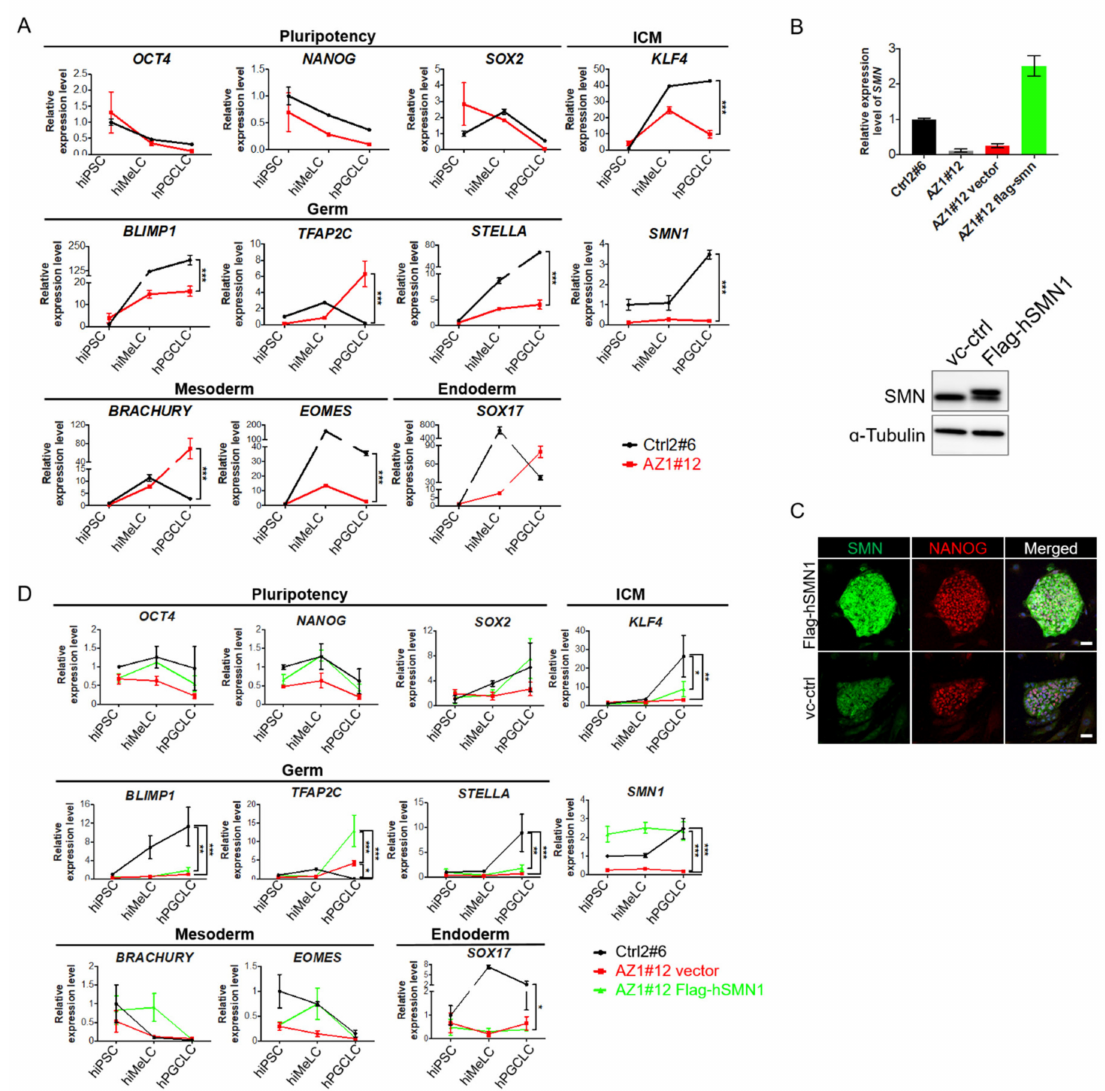
Figure 4. Effect of hSMN1 overexpression on hPGCLC induction in hiPSC from azoospermia patients. ( A ) Expression analysis by real-time RT-PCR of hiPSCs, hiMeLCs, and hPGCLCs. Pluripotent markers including OCT4 , NANOG and SOX2 , as well as ICM marker KLF4 are down-regulated upon differentiation, whereas germ cell markers such as BLIMP1 , TFAP2C, and STELLA are up-regulated during differentiation in control hiPSC (Ctrl2#6). Mesoderm ( BRACHYURY , EOMES ) and endoderm marker ( SOX17 ) show the increasing tendency during differentiation. SMN1 expresses abundantly in cells from Ctrl2#6 hiPSCs compared with AZ1#12 group. Relative expression levels are shown with normalization to GAPDH . Error bars indicate mean ± SEM from three replicates (two-way ANOVA, * p < 0.05; ** p < 0.01; *** p < 0.001). ( B ) Comparison of SMN1 transcripts (upper panel) in Ctrl2#6 and AZ1#12 hiPSC by real-time RT-PCR. Relative fold change of SMN1 is significantly elevated in Flag-hSMN1 overexpressed AZ-hiPSCs (Flag-hSMN1) compared with vector control (vc-ctrl). Western blot analysis demonstrates the exogeneous Flag-tagged SMN protein in SMN overexpressed group (Flag-hSMN1) in 4i culture condition. α -Tubulin is used as internal control (lower panel). ( C ) Immunofluorescent staining of Flag-hSMN1 overexpressed AZ-hiPSCs (Flag-hSMN1) in 4i condition (left panel). Compared with vector control (vc-ctrl), abundancy of SMN (green) is shown in Flag-hSMN1 group. NANOG (red) is stably expressed in those hiPSC lines. Scale bar: 50 µ m. ( C ) Rela-time PCR analysis on Flag-hSMN1 overexpressed AZ-hiPSCs from stages of hiPSCs, hiMeLC to of hPGCLC induction. Markers associated with pluripotency, germ cell development, mesoderm and endoderm differentiation are examined on hPGCLC from control hiPSCs (Ctrl2#6), AZ-hiPSCs introduced with control vector (AZ1#12 vector) and Flag-hSMN1 vector (AZ1#12